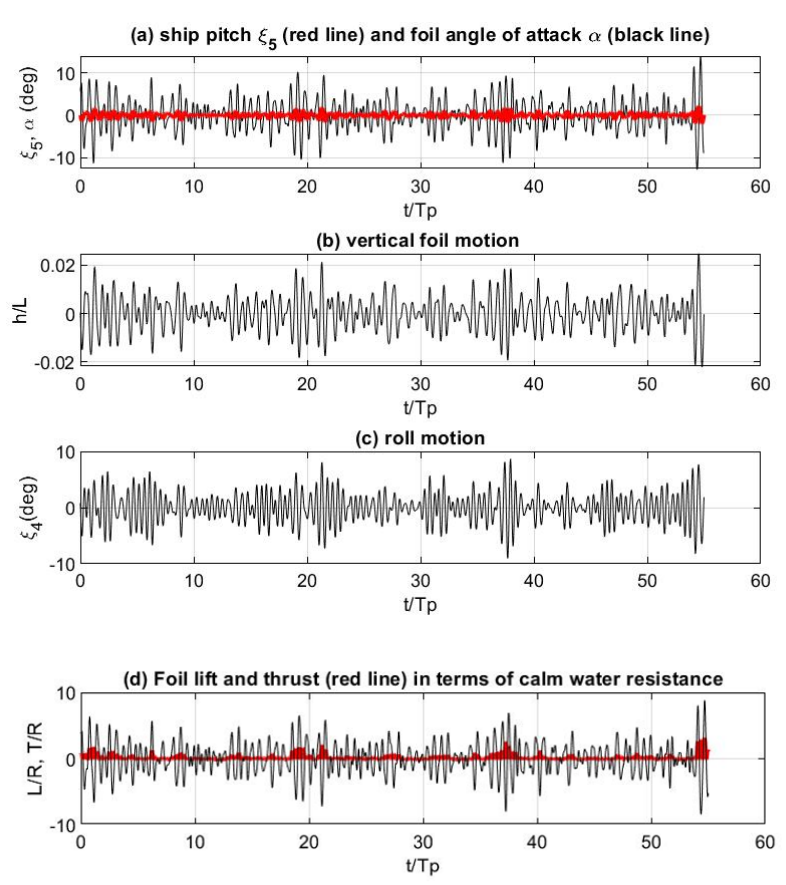
Figure 12. Realization of the vertical motion of the foil (solid line) at the bow of the ship at Fr = 0.25 in comparison with the ship heave motion (dashed line) for the quartering waves propagating at β = 150 ° and represented by the spectrum of Figure 10.